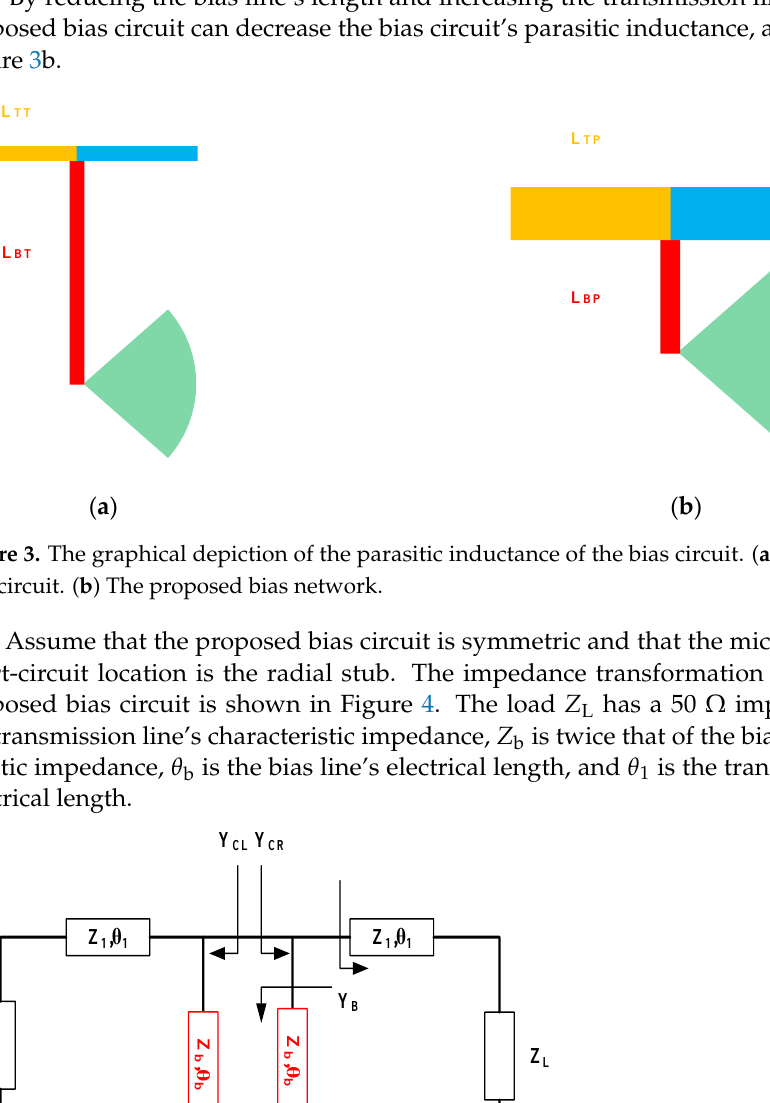
Figure 2. Relationship between the typical bias circuit, the power supply, and the power amplifier.